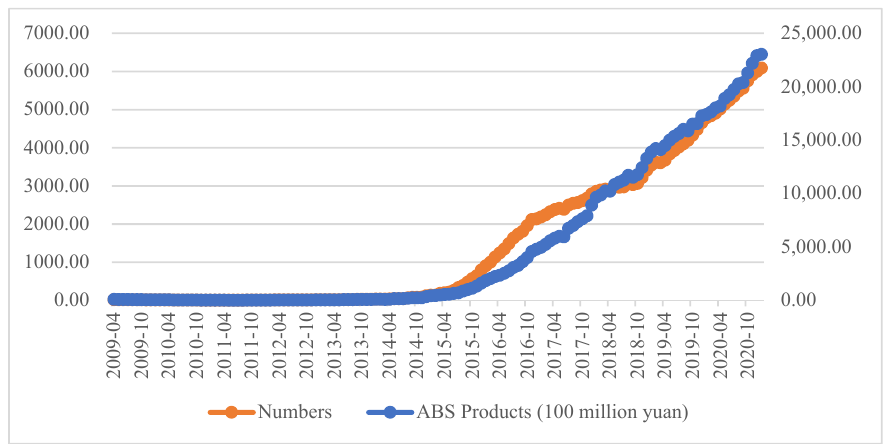
Figure 11. The number and balance of ABS products from 2009 to 2020. Source: wind database.